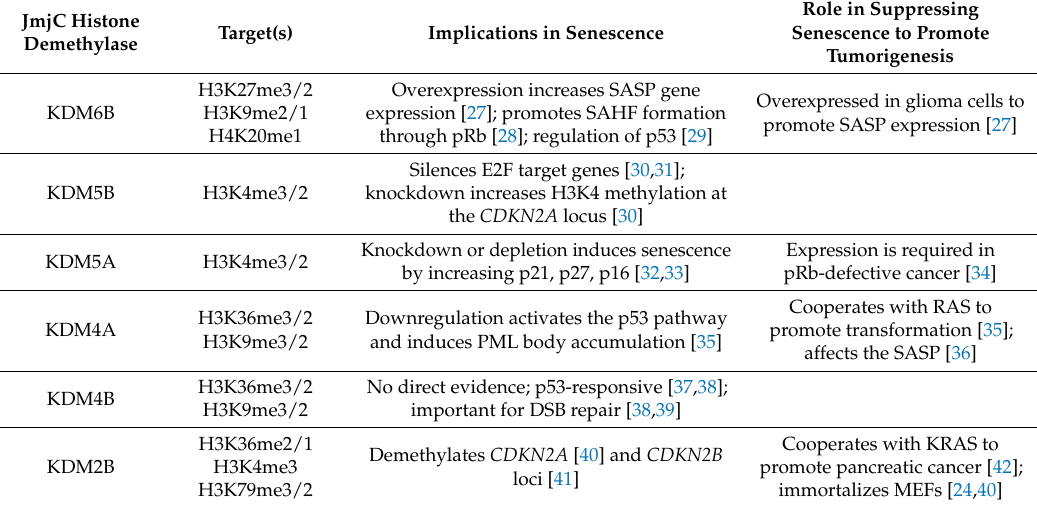
Table 1. Jumonji C (JmjC) histone demethylases play a role in inducing and suppressing cellular